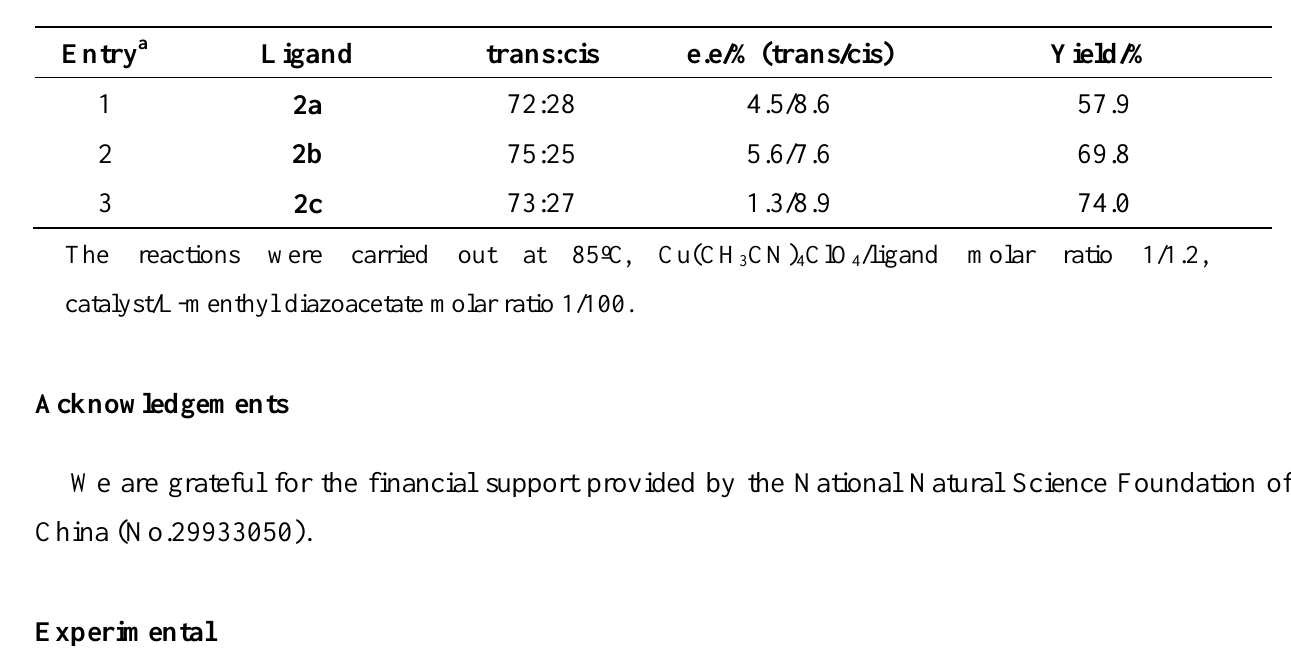
Table 1 . Asymmetric cyclopropanation of 2,5-dimethyl-2,4-hexadiene with